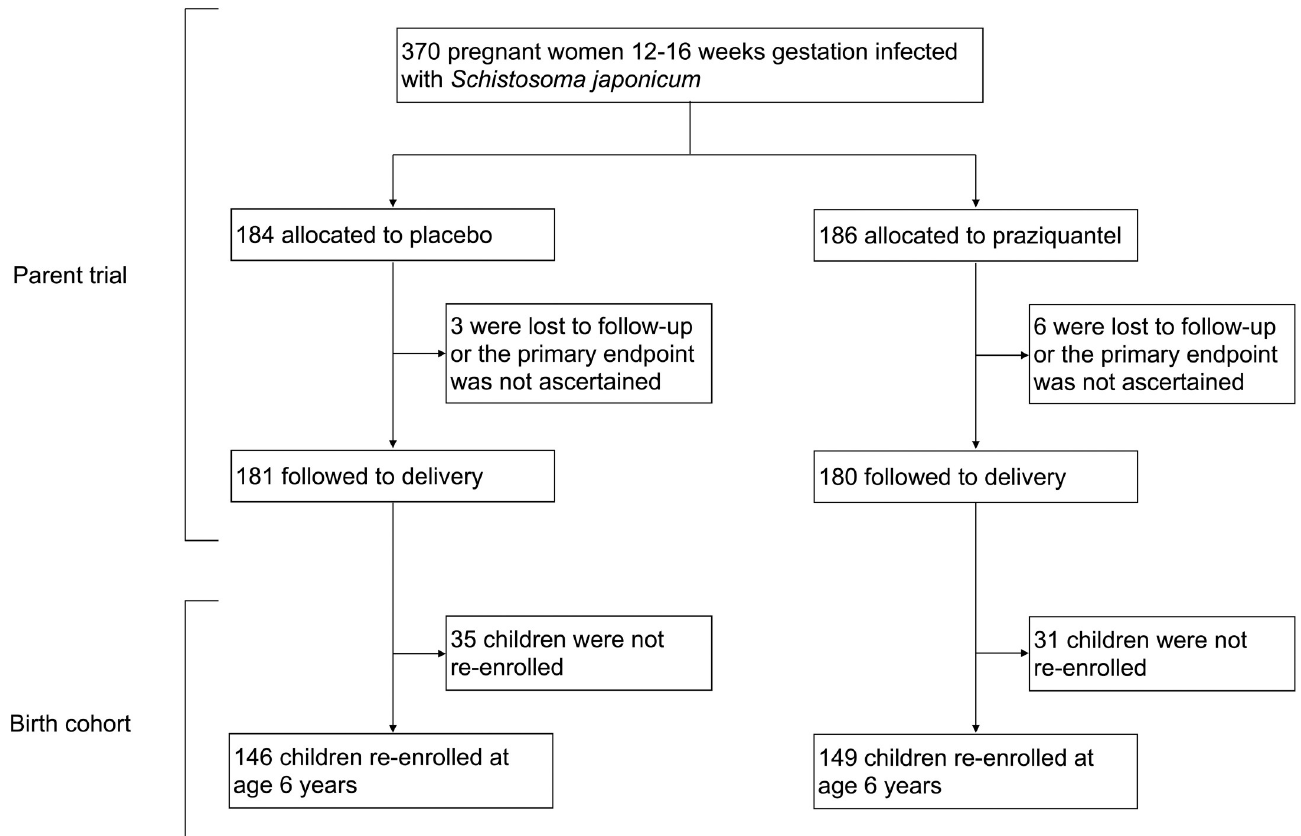
Fig 1. Participants included for